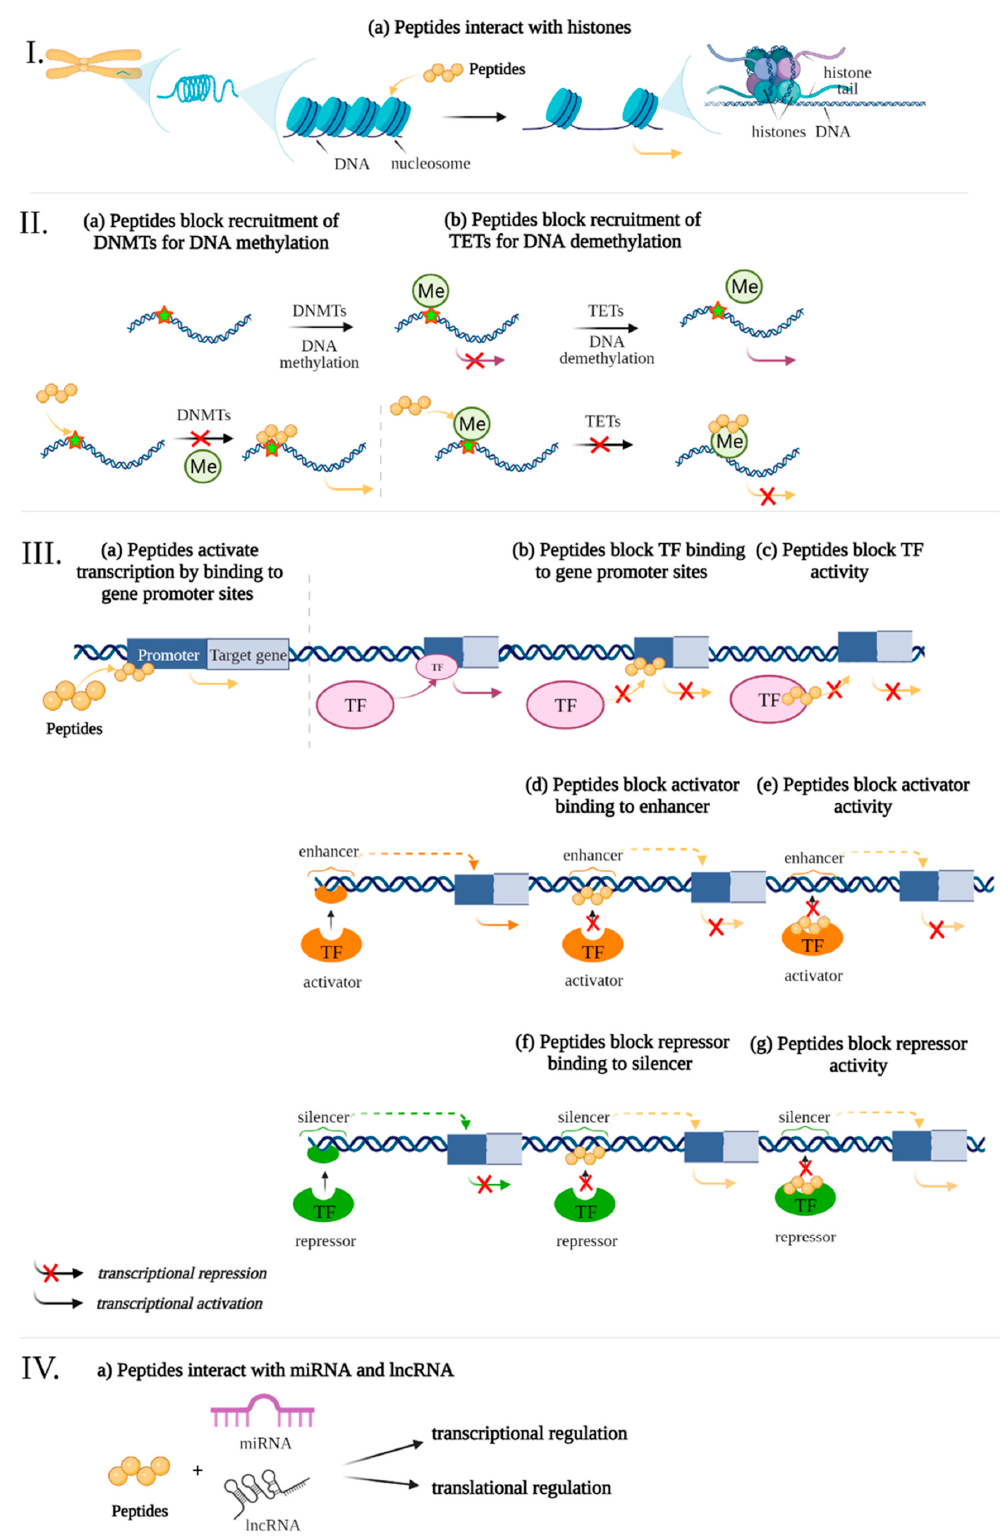
Figure 2. Potential epigenetic mechanisms of gene expression regulation by using ultrashort pep- tides. The levels of regulation: I—chromatin level, II—interference of peptides with DNA Methyla- tion/Demethylation, III—interaction of short peptides with cis-regulatory elements of the genome and transcription factors, IV—RNA level. Note: DNMTs—DNA methyl- transferases, Me—methylation, TF—transcription factors, TETs—translocation enzymes. (figure created with BioRender.com, accessed on 25 February